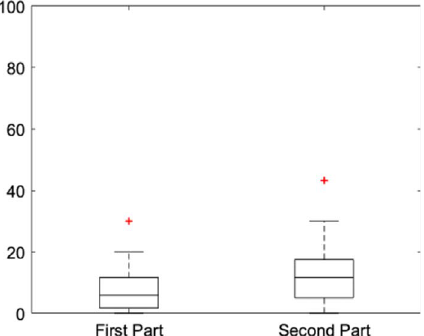
Figure 9. NASA-TLX scores obtained for the fi rst and the second part of the evaluation.